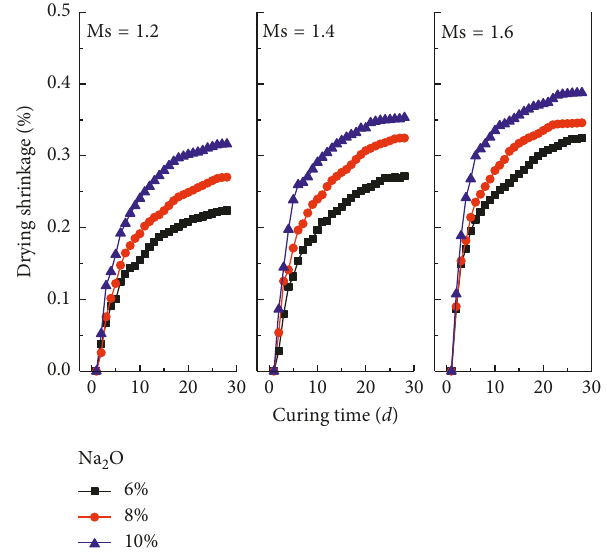
Figure 8: The effects of silicate moduli and Na drying shrinkage of AAS mortars.